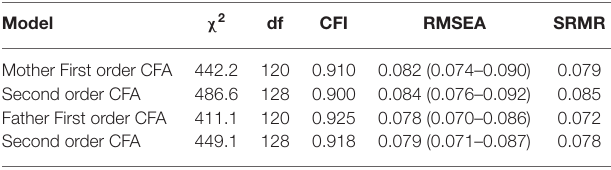
TABLE 2 | Model fit of the six scale CFRT in CFA. Model